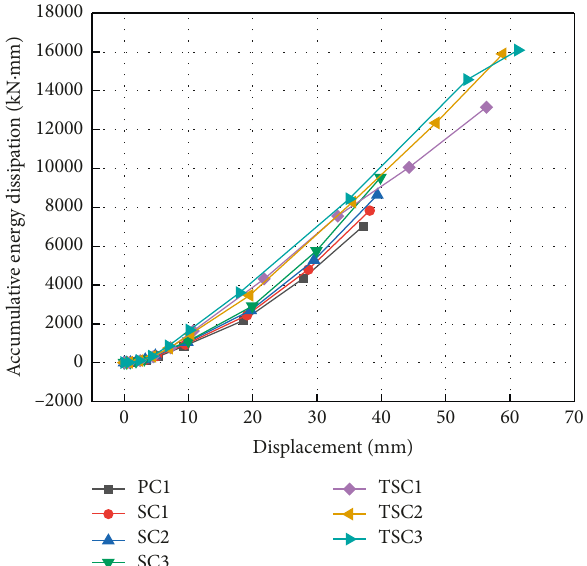
Figure 10: Accumulative energy dissipation of the specimens.